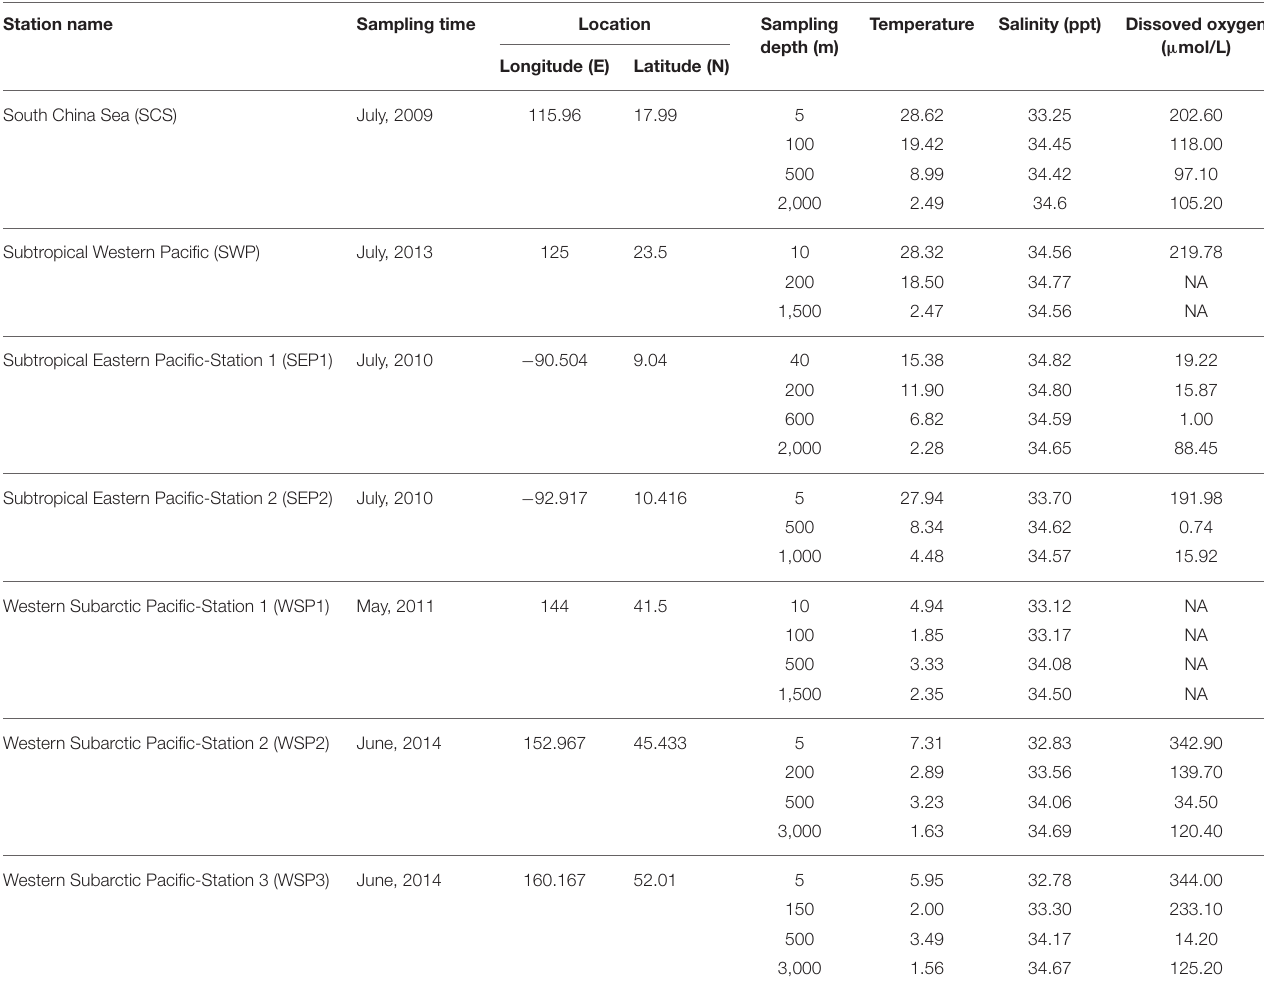
TABLE 1 | Characteristics of the sampling